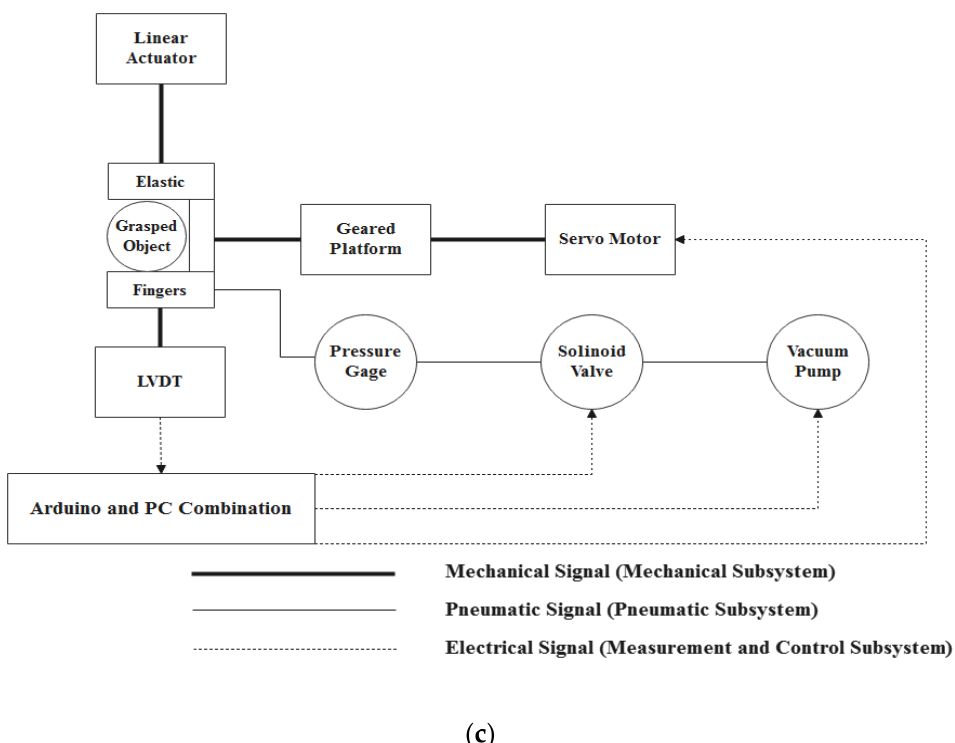
Figure 2. ( a ) The two-finger robotic hand. ( b ) Schematic of the load-carrying mechanism. ( c ) Block diagram of the system.